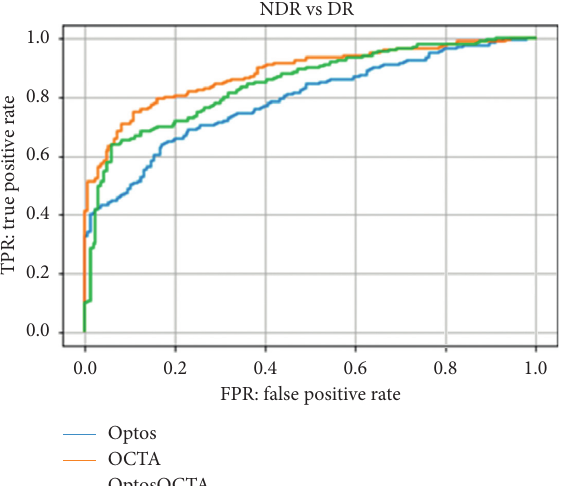
Figure 5: Receiver-operating characteristic curve for test 1 (no apparent diabetic retinopathy [NDR] or diabetic retinopathy [DR]) for Optos, optical coherence tomography angiography (OCTA), and Optos OCTA images. The order of imaging methods used based on the accuracy of their results was as follows: OCTA, Optos OCTA, and Optos.